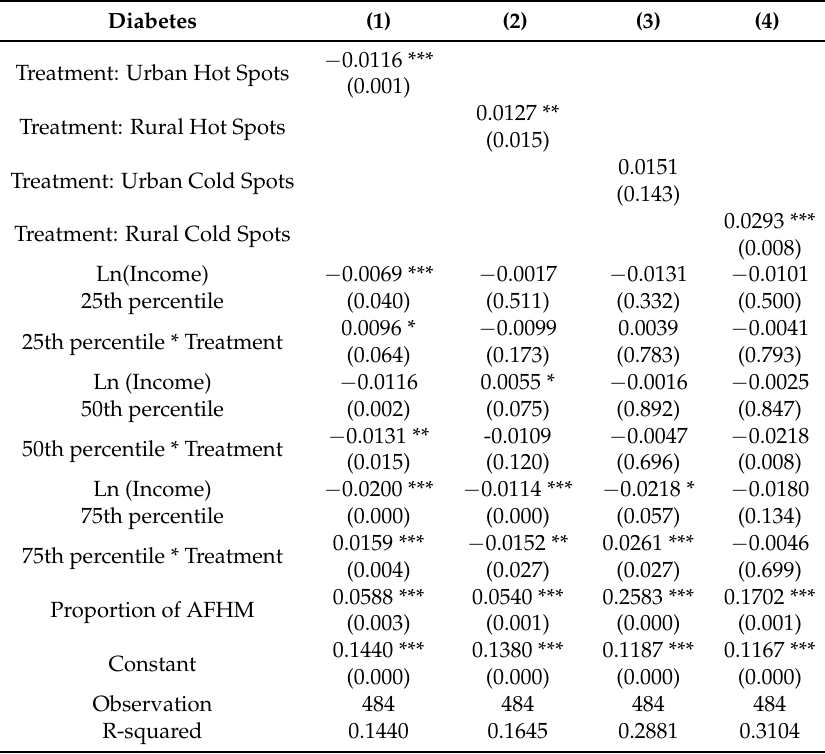
Table A5. Propensity score weighting results for